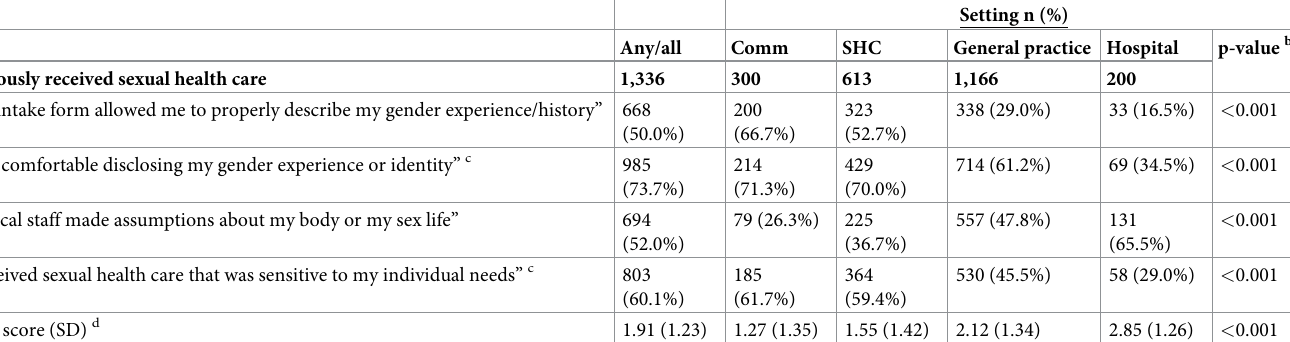
Table 1. Experiences a of gender insensitivity when receiving sexual health care among a sample of trans and gender diverse people in Australia (n = 1,618), overall and by health